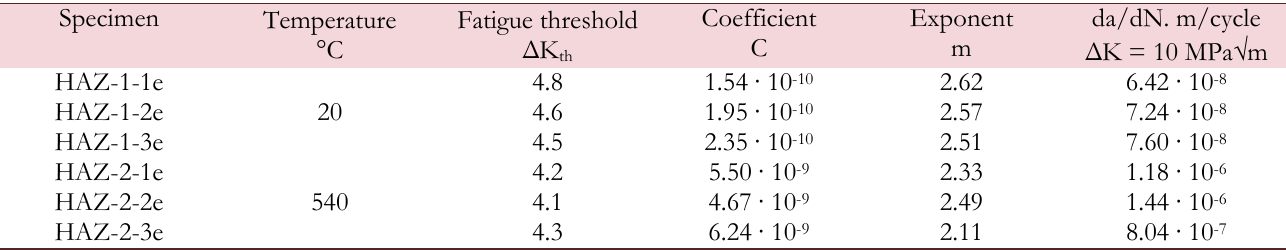
Table 9: Fatigue crack growth parameters for specimens with notches in exploited